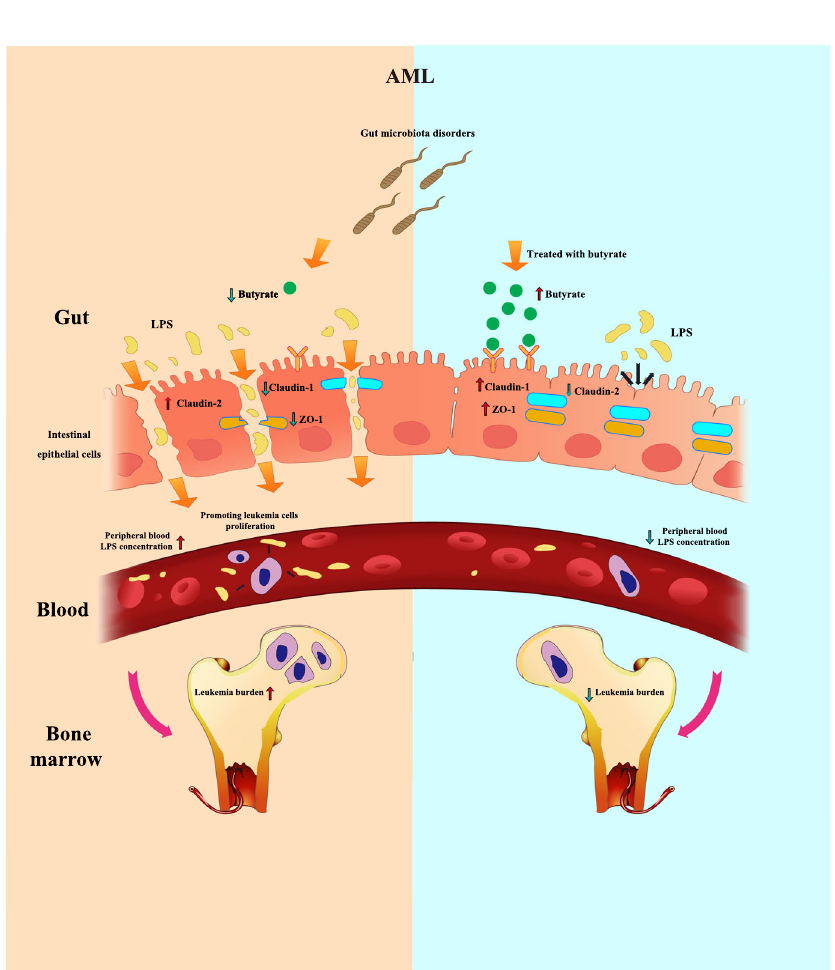
Fig. 8 Gut microbiota regulates AML via alteration of intestinal barrier function and LPS blood concentration. Gut microbiota disorders in AML lead to a decrease in intestinal butyrate. Decreased butyrate weakens gut barrier function by altering tight junction proteins (claudin-1, claudin-2, ZO-1). Dysregulation of intestinal barrier function allows LPS leakage into blood, which in turn promotes the proliferation of AML cells and accelerates AML progression. These effects could be reversed by treatment with butyrate or FITC-dextran assay . Food and water were withheld from all mice for 4 h. FITC- dextran was administered by a 20G-1.5-inch fl exible intragastric gavage needle at a